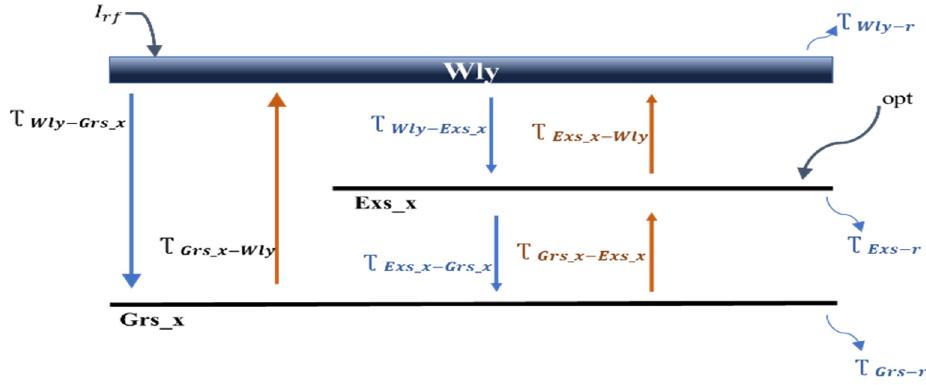
Figure 1. Schematic representation of carrier dynamics for xth QD subgroup.